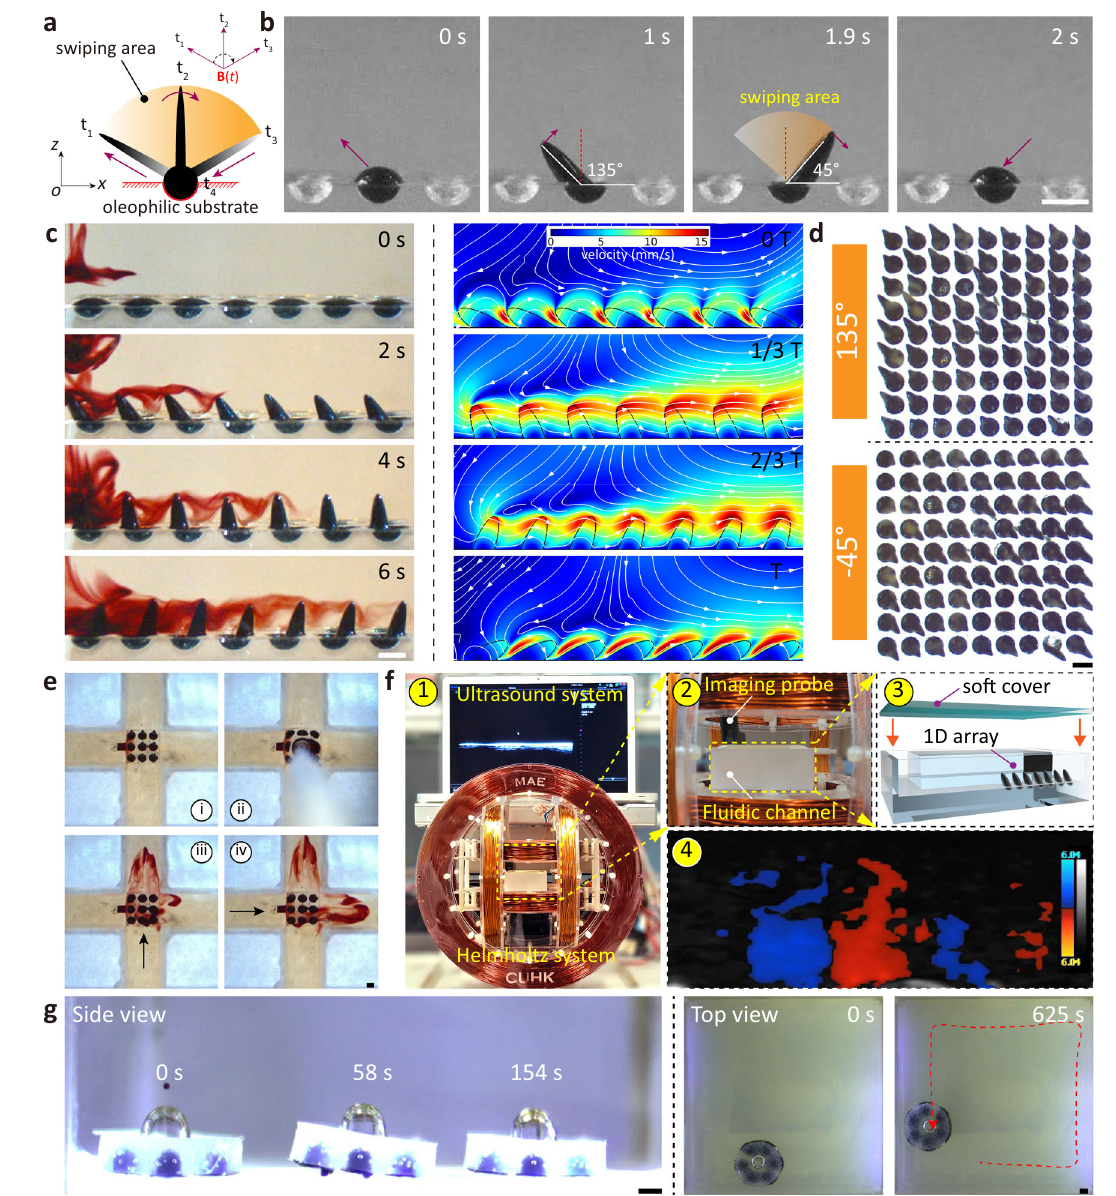
f Ultrasound doppler imaging visualization of liquid cilia array pumping porcine blood in enclosed channels. The experimental setup for blood transporting on liquid cilia arrays consists of a Helmholtz system with an ultrasound system. Color bar represents Doppler signal. g Demonstration of the potential of liquid cilia matrix as mobile soft robots. The substrate of the liquid cilia is a transparent resin material. Scale bars, 2